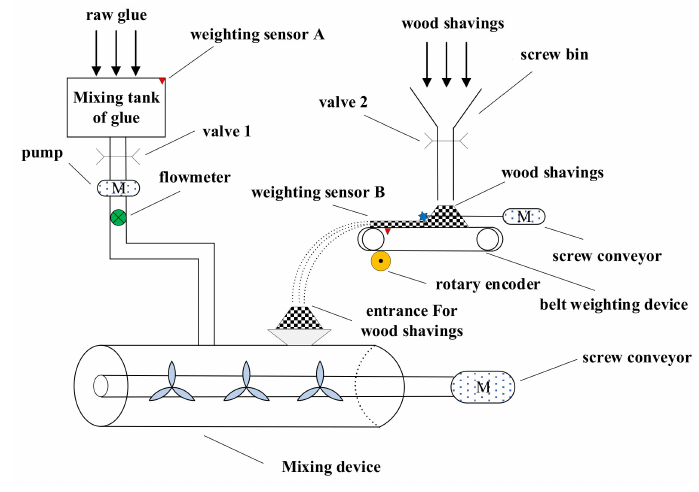
Figure 1. The schematic diagram of particleboard glue system. The basic structure of a commonly used closed-loop control system for particleboard glue flow is shown in Figure 2. The practical flow value obtained by the electromagnetic flowmeter is compared with the ideal flow value, and then the error is sent to the controller. In order to reduce the error, the controller constantly adjusts the frequency of the converter to change the motor speed, so that the practical flow output by the glue pump is equal to the ideal flow.